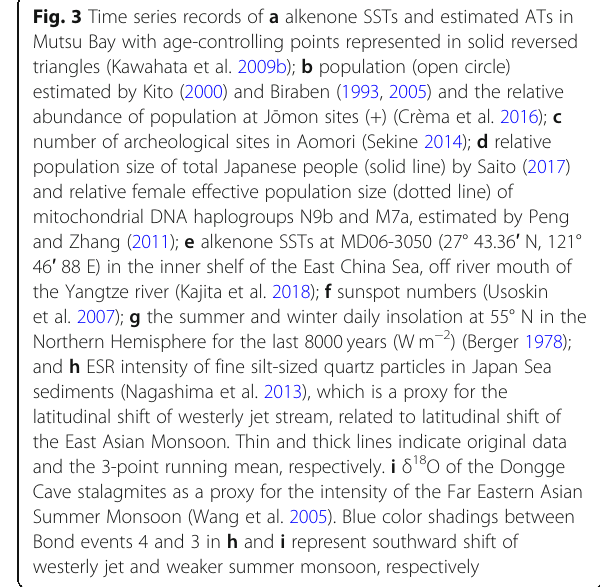
Fig. 3 Time series records of a alkenone SSTs and estimated ATs in Mutsu Bay with age-controlling points represented in solid reversed triangles (Kawahata et al. 2009b); b population (open circle) estimated by Kito (2000) and Biraben (1993, 2005) and the relative abundance of population at J ō mon sites (+) (Crèma et al. 2016); c number of archeological sites in Aomori (Sekine 2014); d relative population size of total Japanese people (solid line) by Saito (2017) and relative female effective population size (dotted line) of mitochondrial DNA haplogroups N9b and M7a, estimated by Peng and Zhang (2011); e alkenone SSTs at MD06-3050 (27° 43.36 ′ N, 121° 46 ′ 88 E) in the inner shelf of the East China Sea, off river mouth of the Yangtze river (Kajita et al. 2018); f sunspot numbers (Usoskin et al. 2007); g the summer and winter daily insolation at 55° N in the Northern Hemisphere for the last 8000 years (W m − 2 ) (Berger 1978); and h ESR intensity of fine silt-sized quartz particles in Japan Sea sediments (Nagashima et al. 2013), which is a proxy for the latitudinal shift of westerly jet stream, related to latitudinal shift of the East Asian Monsoon. Thin and thick lines indicate original data and the 3-point running mean, respectively. i δ 18 O of the Dongge Cave stalagmites as a proxy for the intensity of the Far Eastern Asian Summer Monsoon (Wang et al. 2005). Blue color shadings between Bond events 4 and 3 in h and i represent southward shift of westerly jet and weaker summer monsoon,